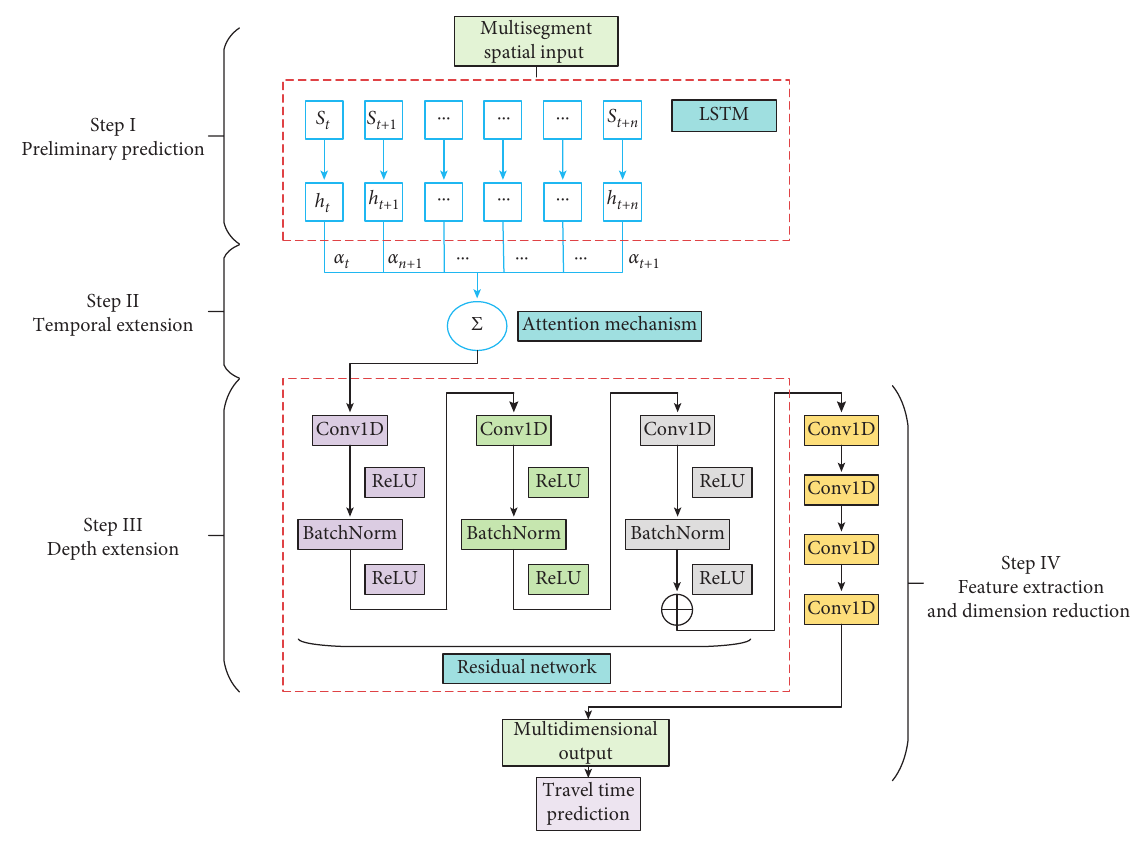
Figure 1: LSTM-CNN model structure.